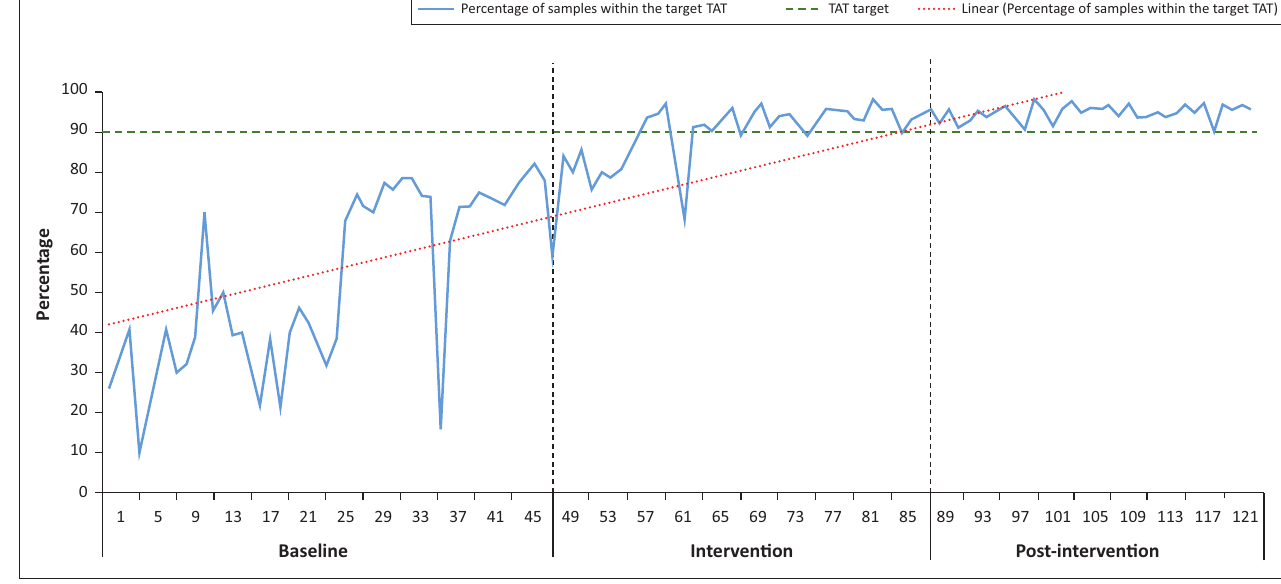
FIGURE 1: The percentage of within cut-off turn-around times for creatinine testing at a high-volume laboratory across 122 weeks after implementation of a weekly dashboard, Gauteng, South Africa,